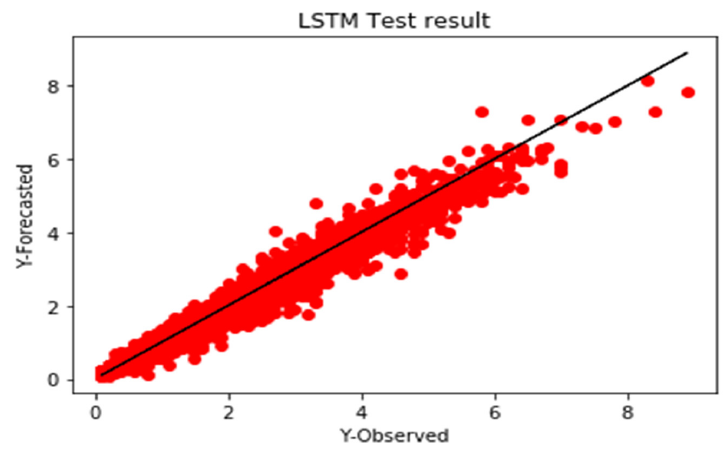
Figure 12. LSTM-based wave height model error analysis.